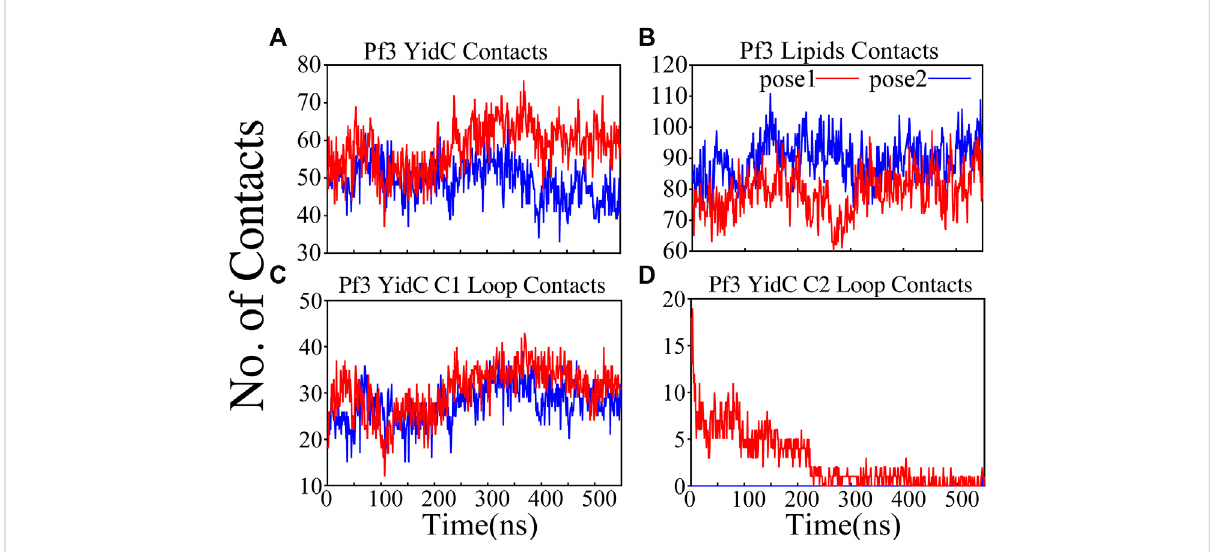
FIGURE 4 Pf3 coat protein overall interaction with YidC and POPE lipid tails in both the docking model simulations. (A,B) Respective number of YidC and lipid interactions with the Pf3 coat protein in pose1 (red) and pose2 (blue), shown as a function of time. (C,D) Number of contacts between Pf3 coat protein and the C1 and C2 loops of YidC, shown as a function of